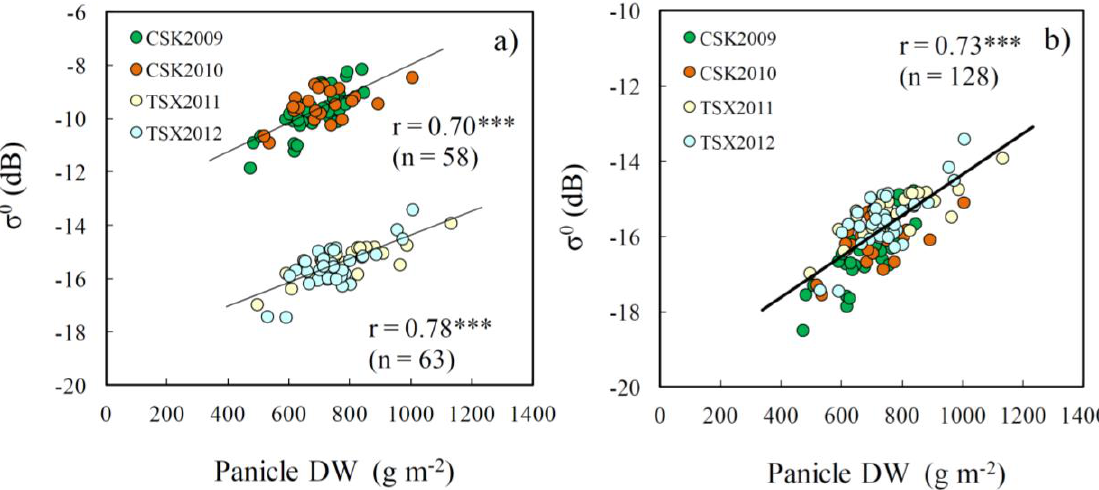
Figure 8. Relationship of X-VV σ 0 from CSK and TSX with the panicle dry biomass. ( a ) Comparison using the original σ 0 from the two sensors; and ( b ) comparison using the combined data from the two sensors after offset correction. *** indicates the statistical significance at